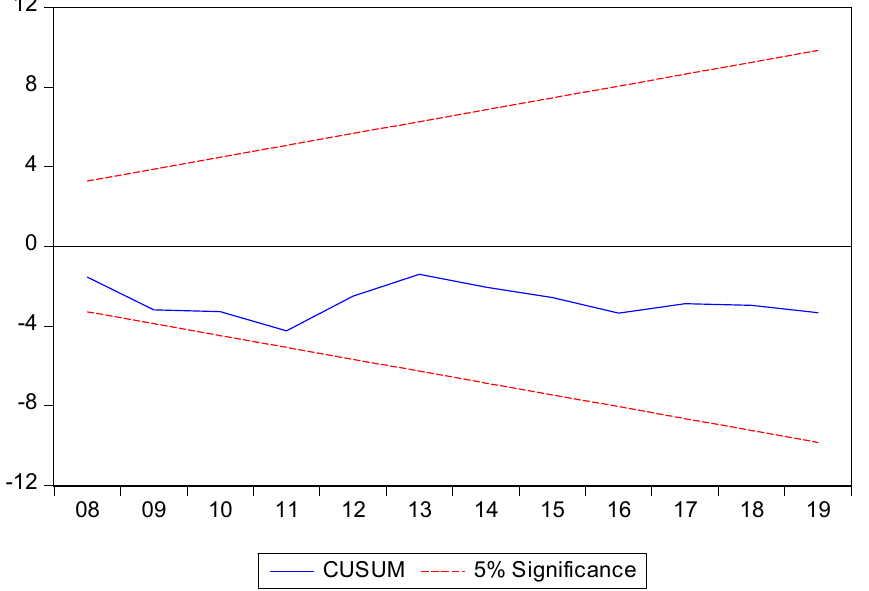
Figure 2. Recursive estimates CUSUM test. CUSUM = Cumulative Sum Control Chart. Table 6. Pairwise Granger Causality Tests. Sample: 2003–2019. Lags: 2. Null Hypothesis: Obs F-Statistic